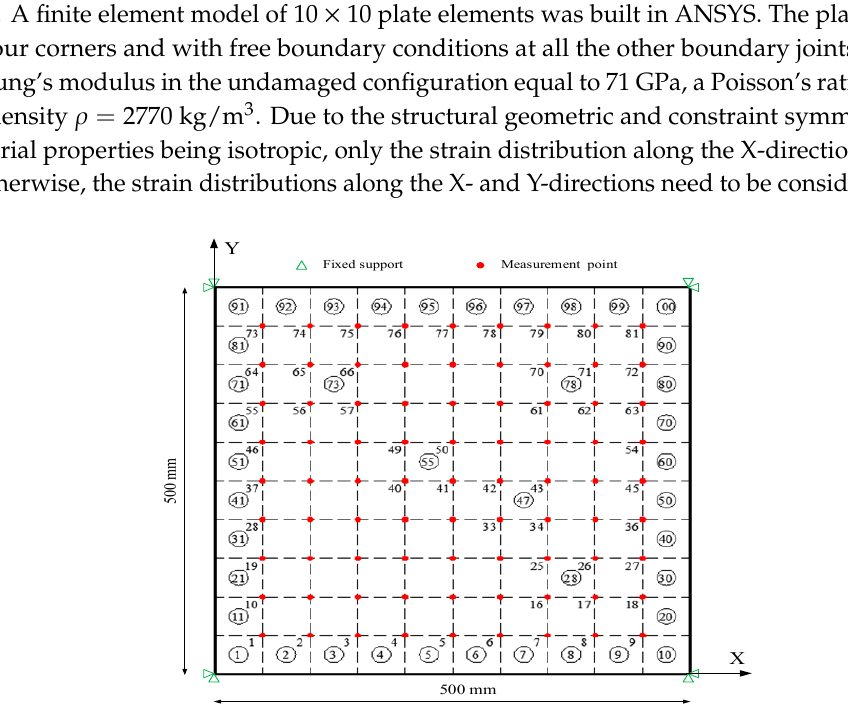
Figure 1. The numerical model of the plate: grid of 81 measurement points (red dots).